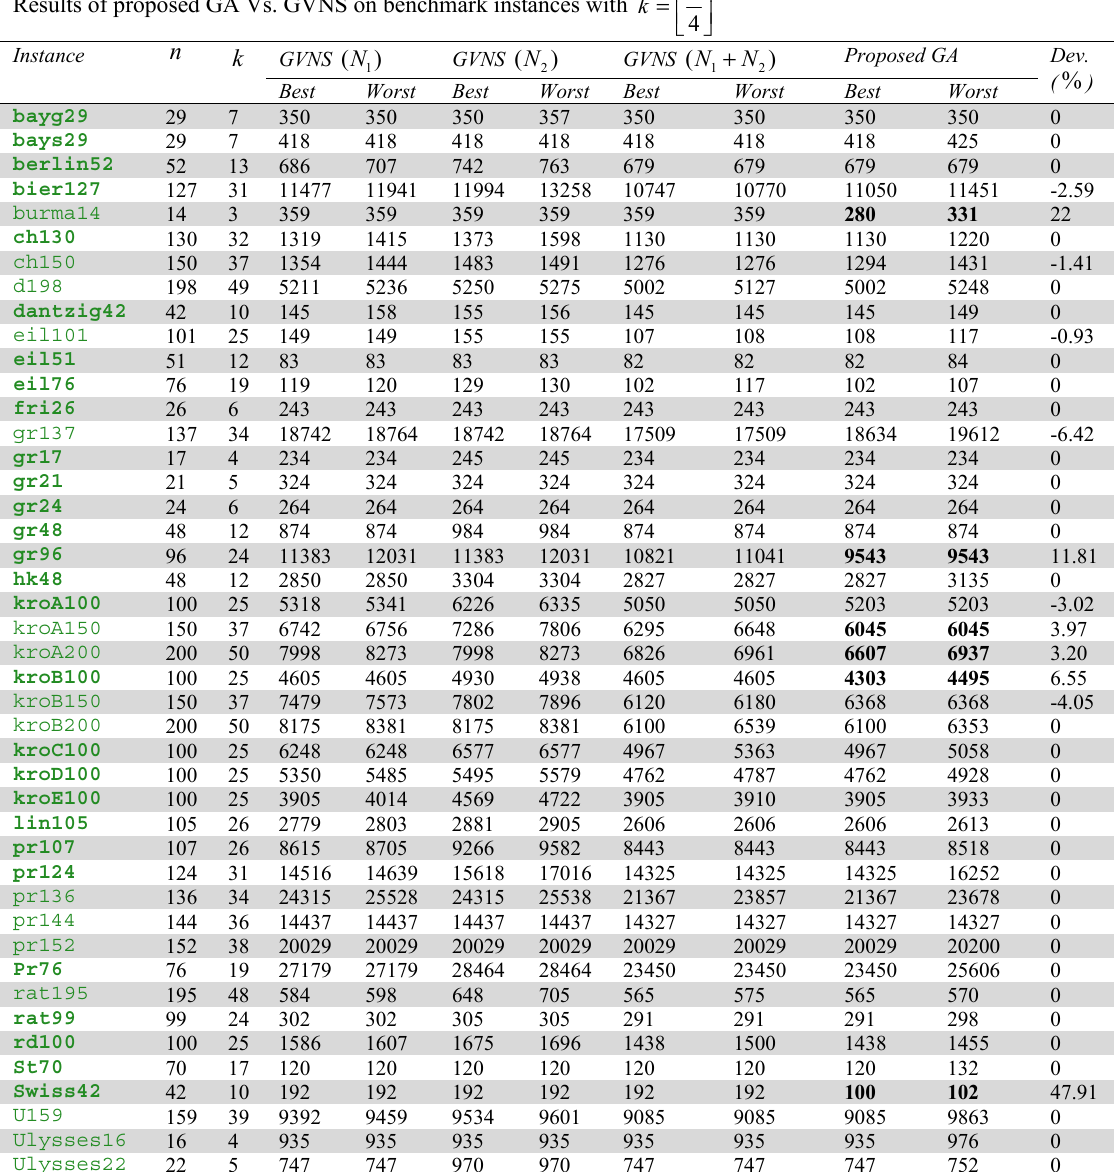
Fig. 8. Salesman route plans for burma14 with distinct k values by proposed GA Results of proposed GA Vs. GVNS on benchmark instances